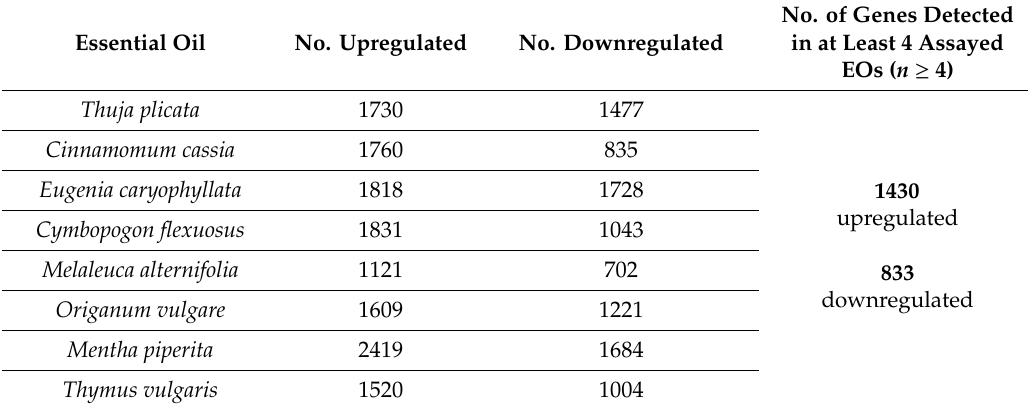
Table 1. The number of up- or downregulated genes presented in at least half of the samples after exposure to selected essential oils